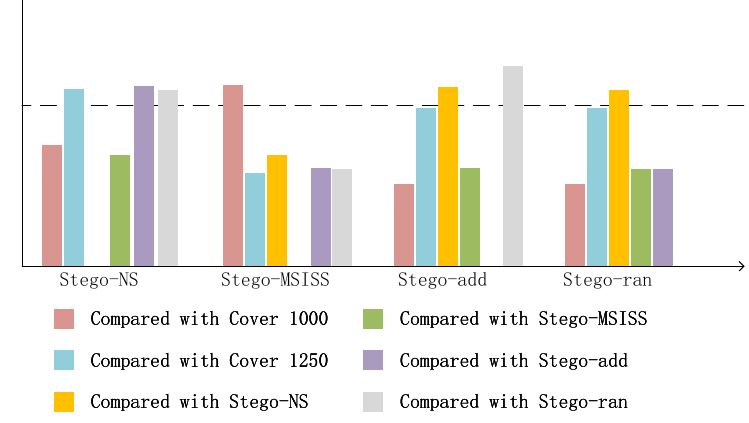
Figure 6. The undetectability possibility results among various kinds of images.